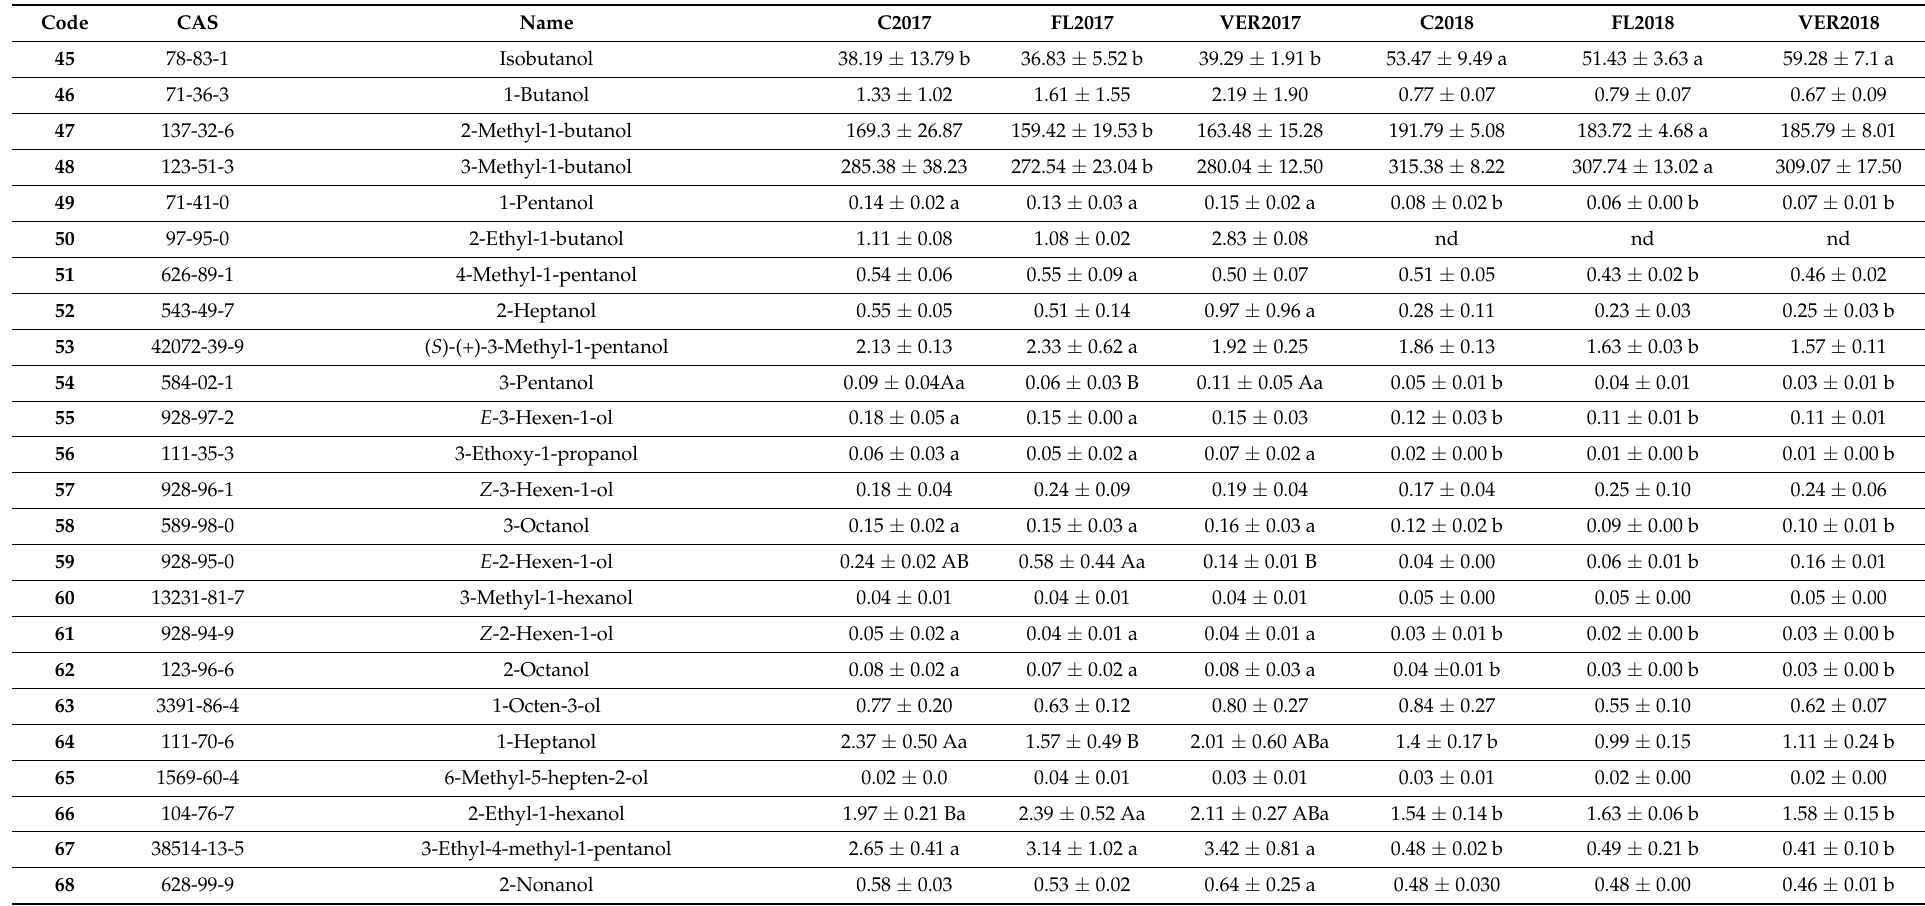
Table 4. Effects of defoliation treatments and vintage on concentrations of aliphatic alcohols ( µ g/L). (The quantification was conducted by using a linear standard calibration with 1-hexanol.) C = control; FL = removal of six leaves before flowering; VER = removal of six leaves at the end of